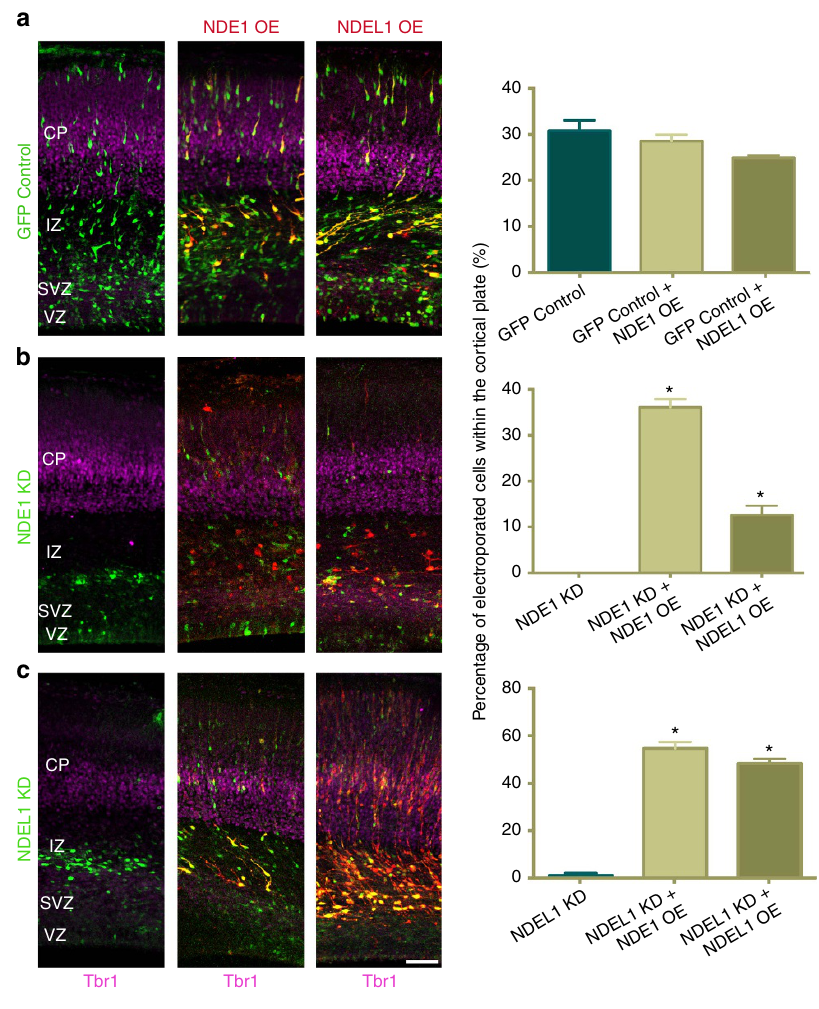
Figure 5 | NDE1 or NDEL1 overexpression largely rescues the neuronal migration defects seen after knockdown of either protein. To test for RNAi rescue and functional complementation, embryonic rat brains were co-electroporated at E16 with shRNA to the various conditions with cDNA encoding RNAi-resistant proteins for self-rescue, and standard cDNA for cross-rescue. All the analyses were done at E20. Quantification of the amount of electroporated cells migrating into the cortical plate (CP) is shown at right. ( a ) Overexpression of NDE1 and NDEL1 produced no significant change in the amount of neurons migrating into the CP. ( b ) NDE1 knockdown with overexpression of RNAi-resistant NDE1 rescued neuronal migration into the CP. Overexpression of NDEL1 during NDE1 knockdown partially rescued neuronal migration into the CP. ( c ) Overexpression of RNAi-resistant NDEL1 or NDE1 with NDEL1 knockdown rescued the neuronal migration into the CP, even increasing the fraction of electroporated cells in the CP. Data are presented as mean ± s.e.m., and unpaired t -tests used for all comparisons, * P o 0.05, n ¼ 3 embryonic brains from different mothers. Scale bar, 50